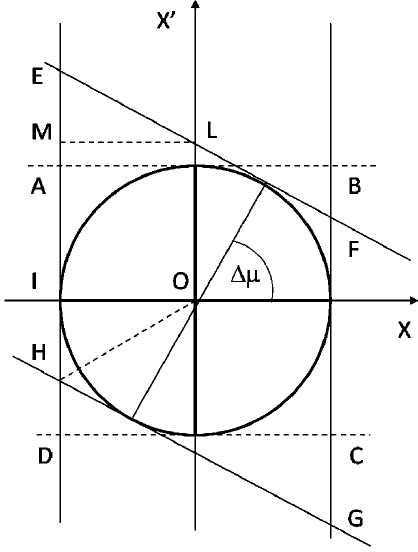
FIG. 2. Collimator acceptance in the normalized phase